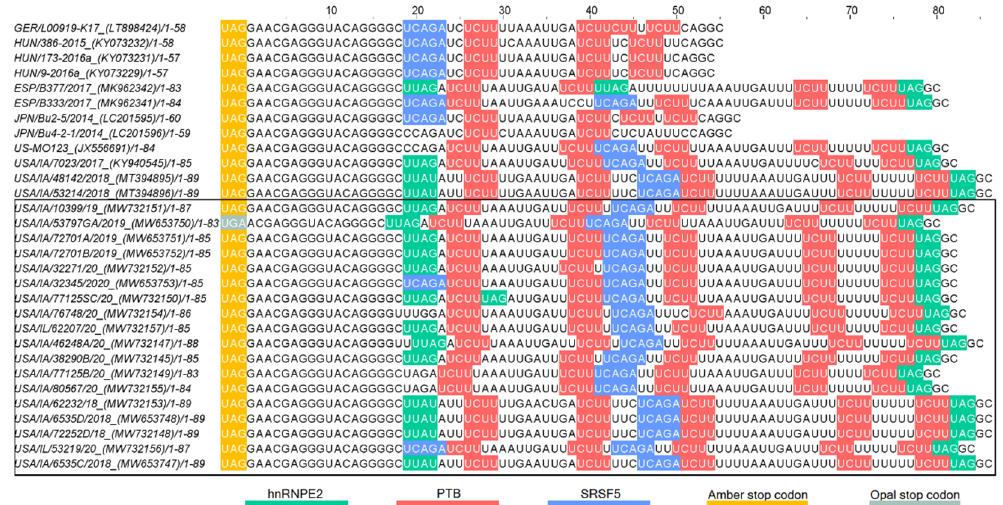
Figure 6. Putative protein binding sites of the 3 ′ UTR of PoAstV3. RNA binding sites for serine/arginine-rich splicing factors 5 (SRSF5 [UCAGA, blue bases]), heterogeneous nuclear ribonucleoprotein E2 (hnRNPE2 [UUAG/UUAU, green bases]) and polypyrimidine tract-binding protein (PTB [UCUU, red bases]). UAG and UGA stop codons in amber and opal boxes, respectively. Sequences identified in this study are denoted by a black box.